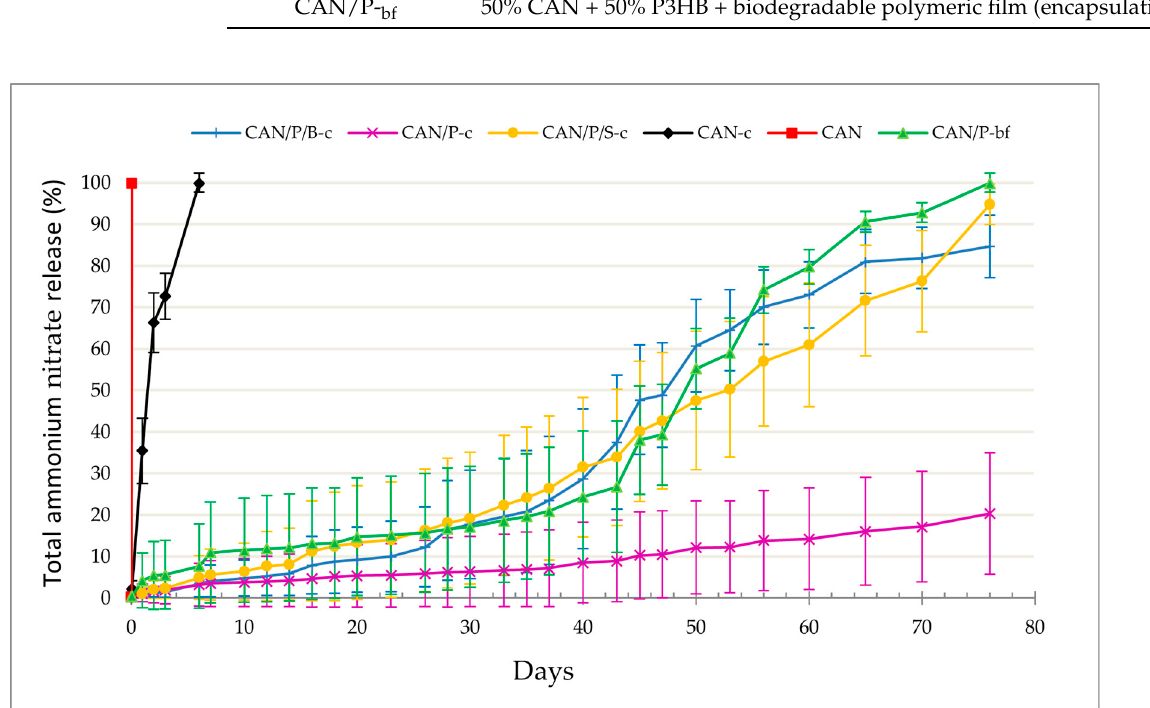
Figure 3. Release of ammonium nitrate (AN) from pellets of different compositions in the aquatic environment as a function of time. Total ammonium nitrate release in% is expressed as mean (n = 10), and the error bars represent the standard deviation. CAN-c: 100% CAN with P3HB coating; CAN/P-c: 50% CAN + 50% P3HB with P3HB coating; CAN/P/S-c: 50% CAN + 25% P3HB + 25% struvite with P3HB coating; CAN/P/B-c: 50% CAN + 50% biomass with P3HB coating; CAN/P-bf: 50% CAN + 50% P3HB encapsulated in biodegradable film; CAN: 100% CAN (positive reference).